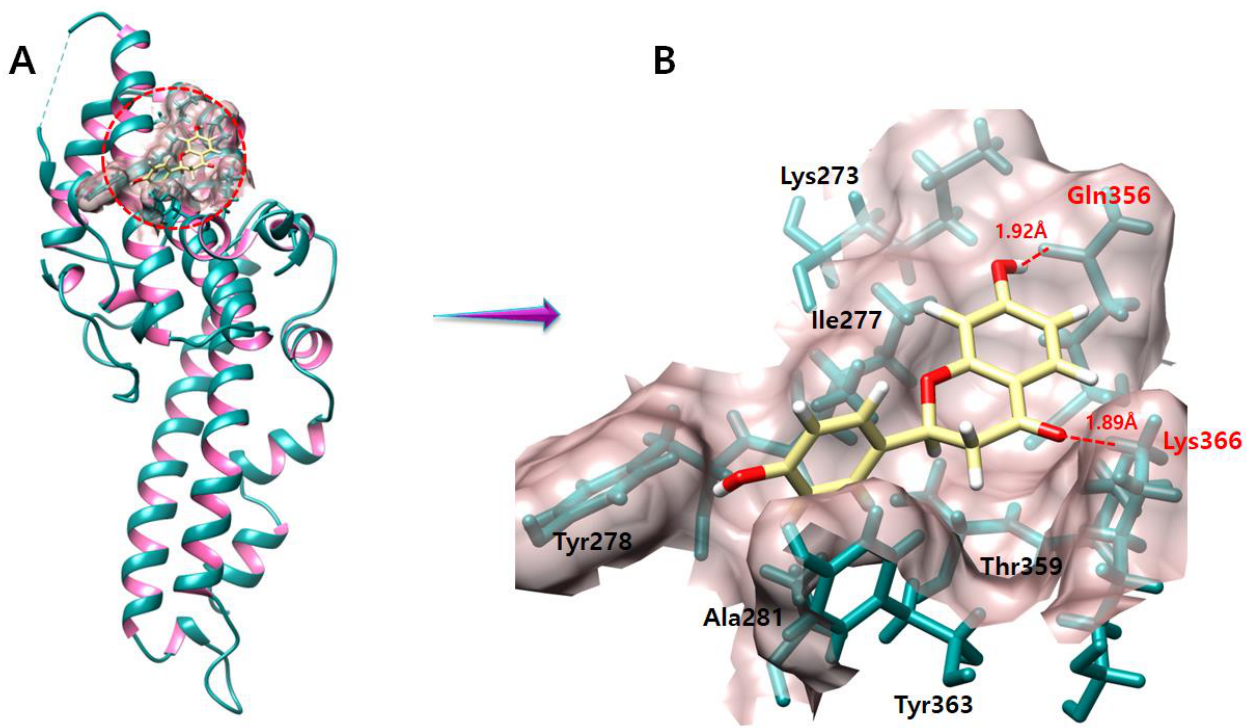
Figure 9. The figure ( A ) shows the liquiritigenin and DBP complex. In figure ( B ) the hydrogen bonds are represented in red color and the bonding residues are also labeled in red color. An oxygen atom of pulchellidine forms a salt bridge with Lys366 with a length of 1.68 Å .